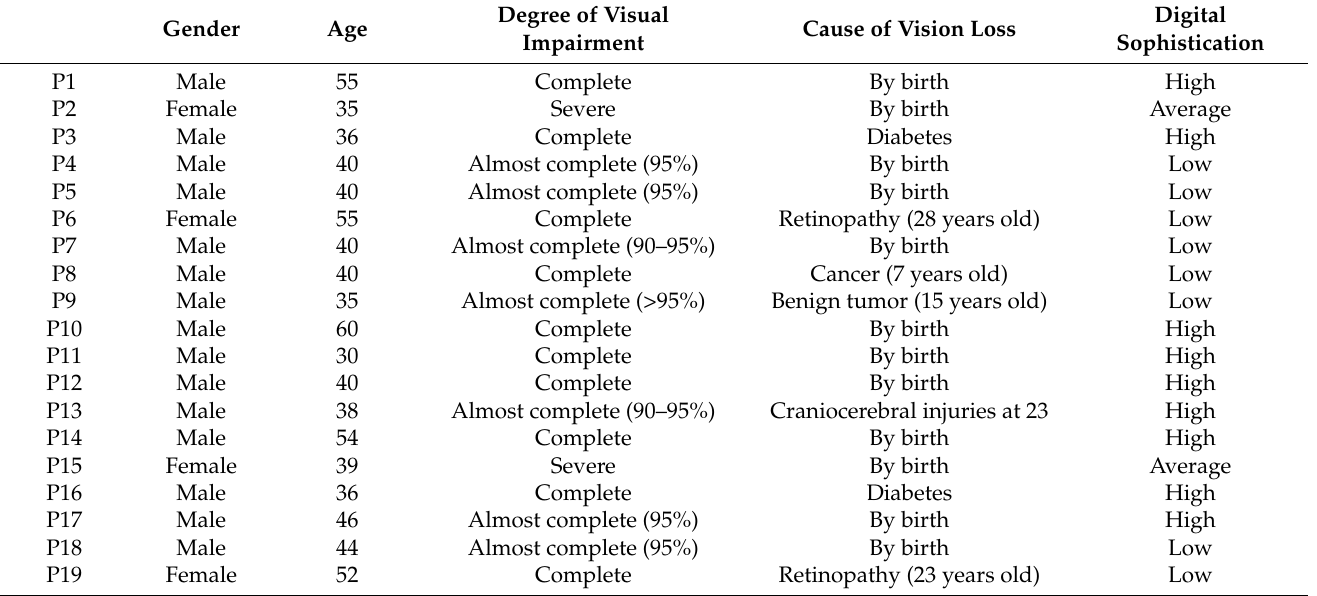
Table 1. Participants’